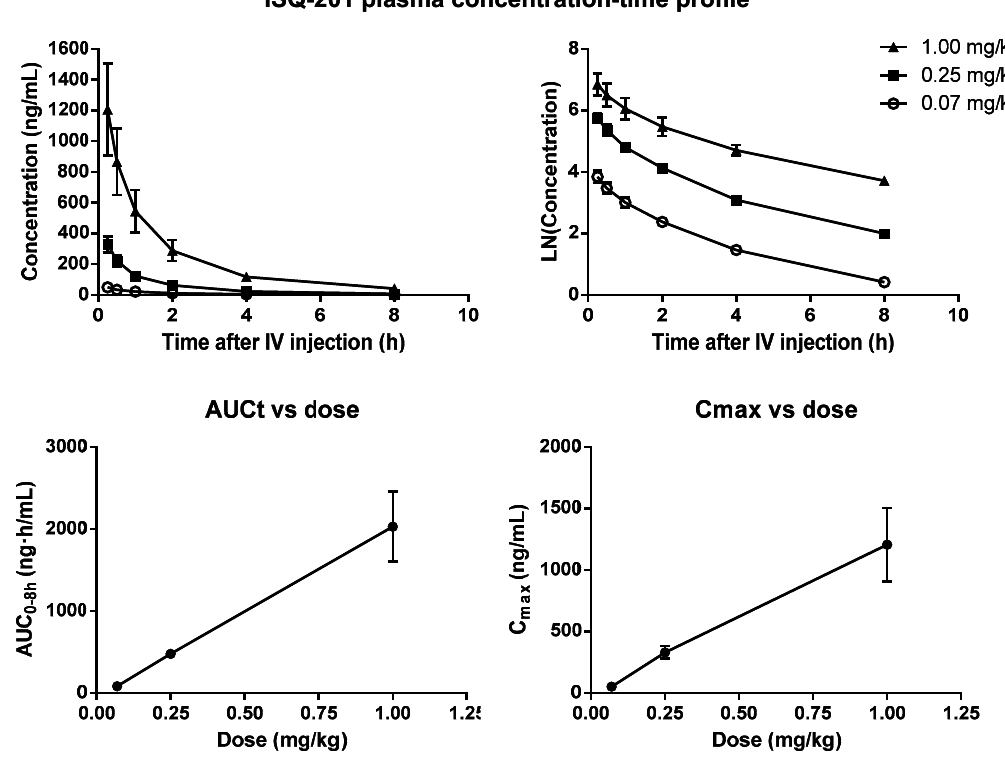
Figure 7. ISQ-201 plasma concentration-time profile after intravenous administration (linear and semi-logarithmic scale in the left and right upper graphs, respectively); and values of AUC 0-8h (AUC t ) and C max versus dose. Data represented as mean ± SE of 6 independent animals. Table 2. Pharmacokinetic parameters of ISQ-201.